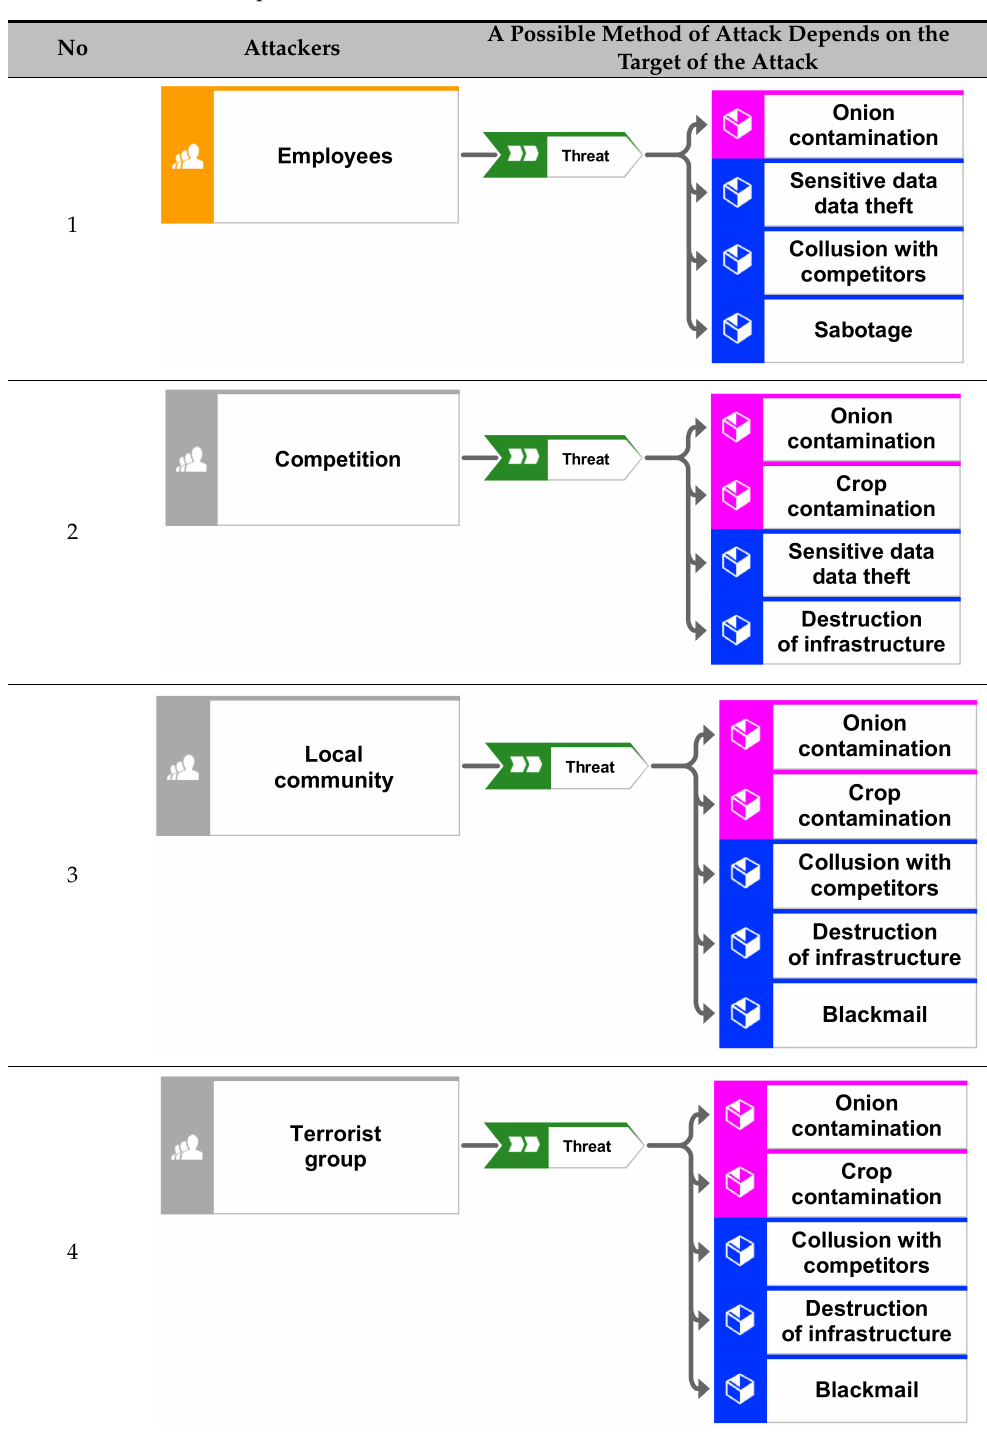
Table 5. Identification of potential attackers.